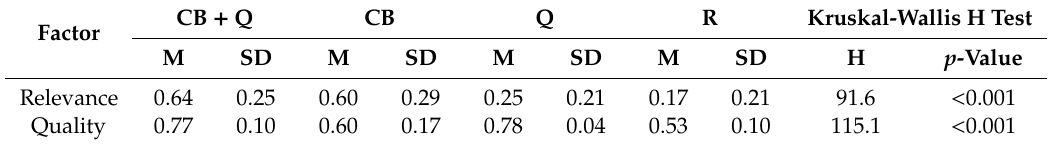
Table 1. Relevance and quality scores of the open educational resources (OER) recommendations.